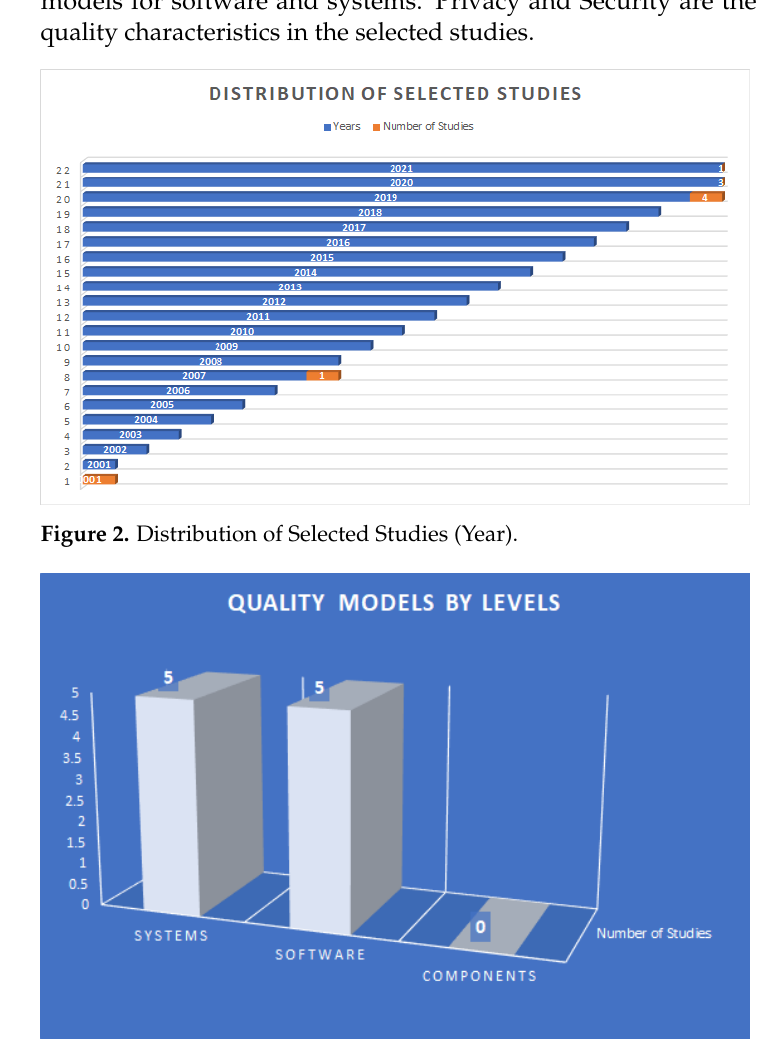
Figure 3. Quality Models by